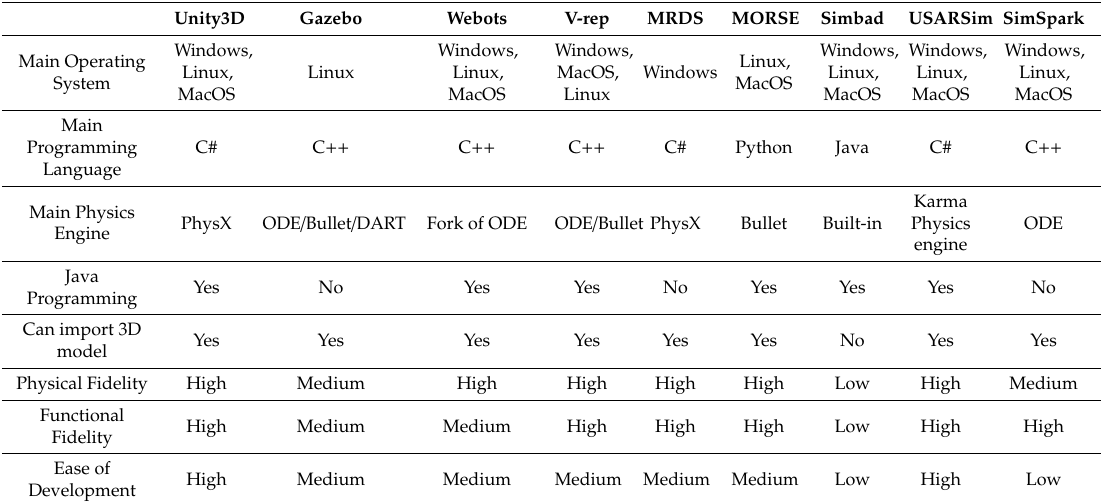
Table 1. Comparison of common types of simulation